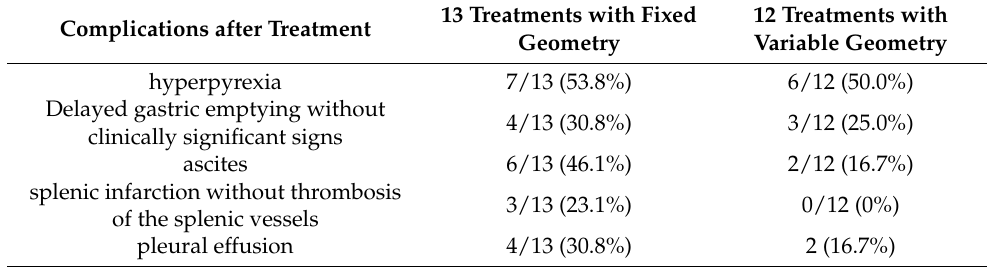
Table 4. Feasibility and Safety